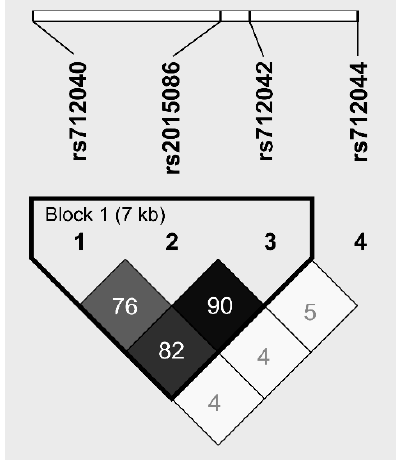
Table 2. Allele carrier and genotype frequencies in patients with IPF and healthy controls.